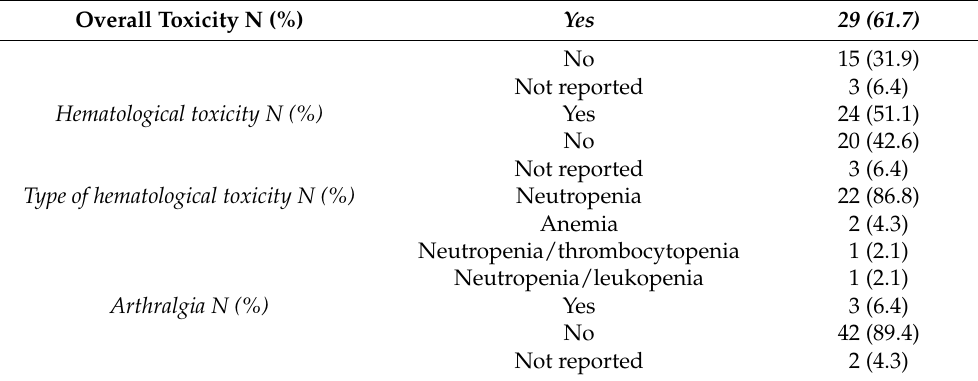
Table 1. Adverse events of treatment with CDK4/6